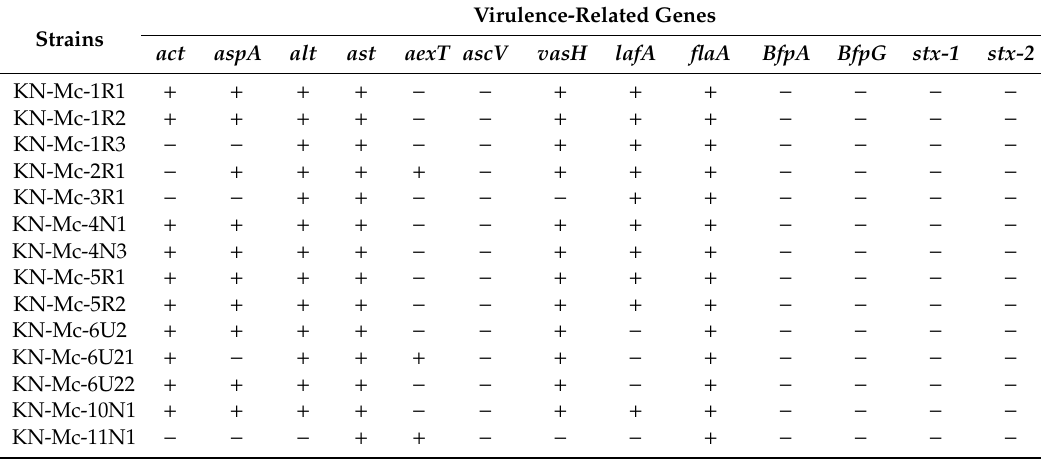
Figure 1. Neighbor-joining phylogenetic tree based on gyrB nucleotide sequences showing the relationships of all Aeromonas isolates reported in this study to some representative type strains of Aeromonas spp. and the outgroup Vibrio cholerae CECT 514 T . The scale bar represents 0.05 nucleotide substitutions per site. Table 2. Presence of the virulence-related genes of 14 Aeromonas